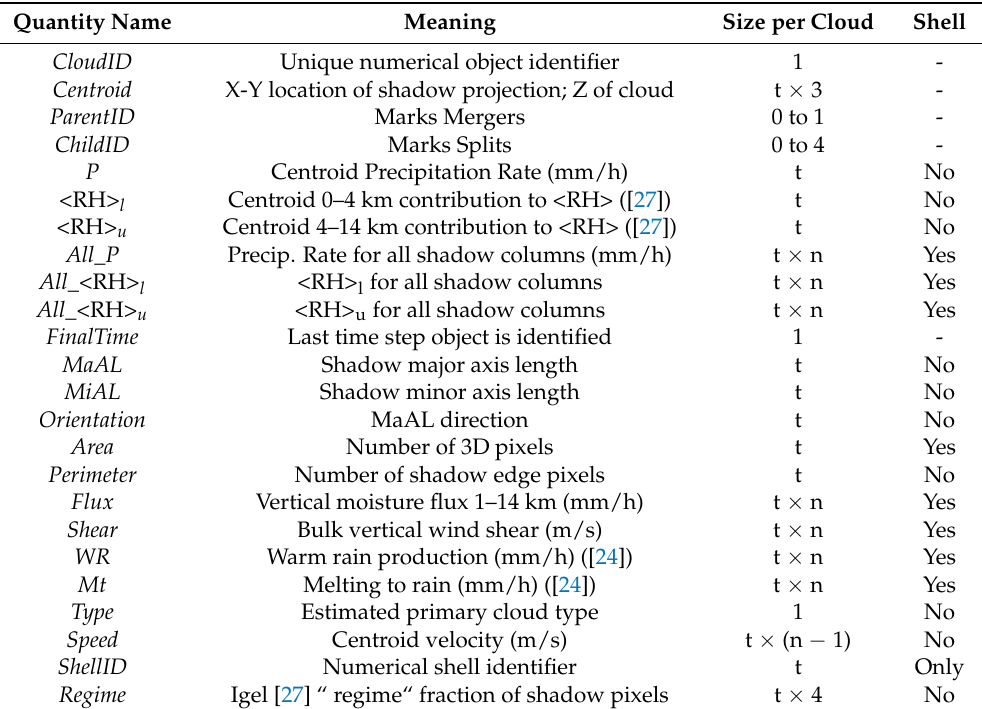
Table 1. Cloud and environmental quantities included in